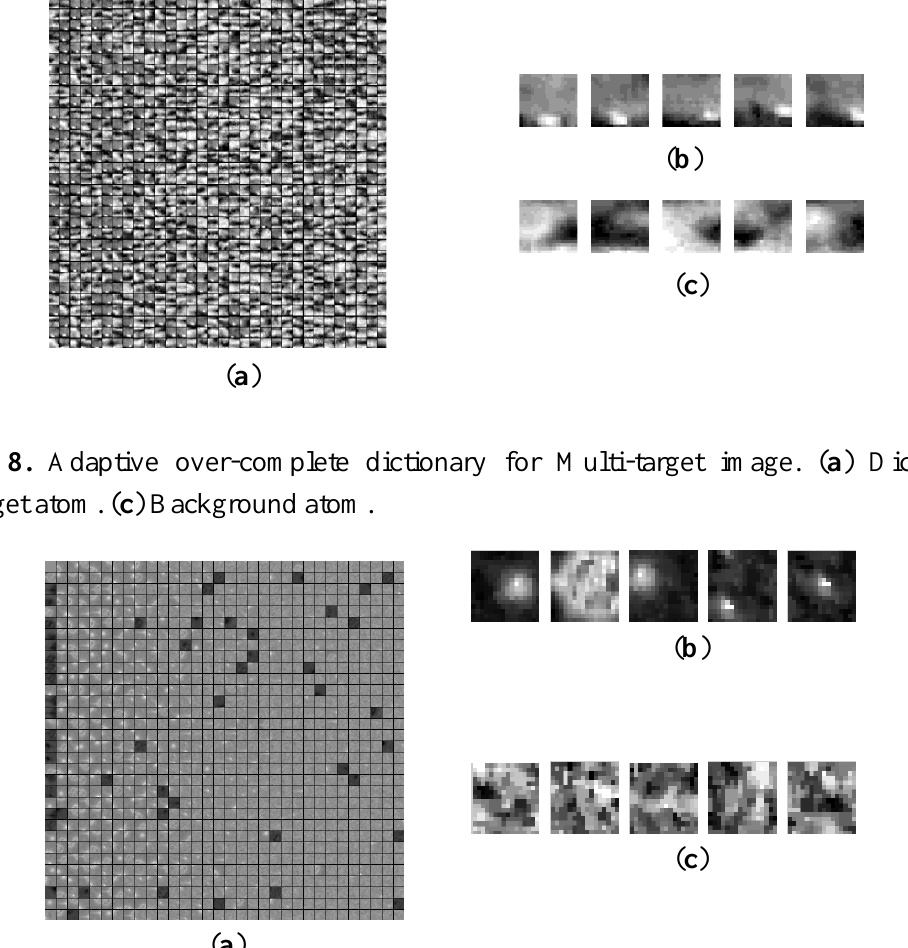
Figure 7. Adaptive over-complete dictionary for cloud image. ( a ) Dictionary. ( b ) Target atom. ( c ) Background atom.